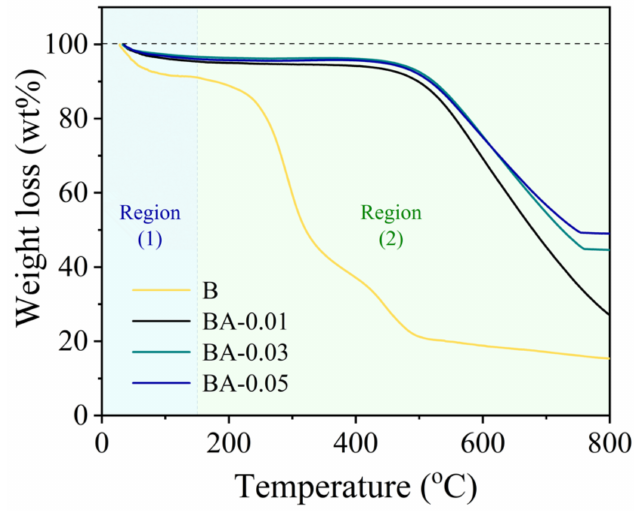
Figure 5. Thermogravimetric analysis of as-synthesized banana stem-based materials.